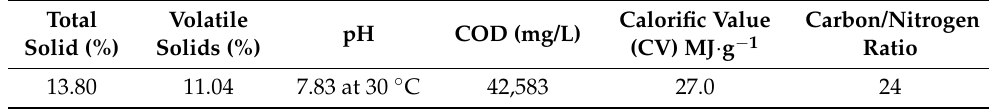
Figure 1. 3D surface plot of the dataset points and the model mesh for methane yield. [CH 4 reported in %, X and Y reported in %/°C, and % respectively]. Table 1. Characterization of cow dung used in the Table 1. Characterization of cow dung used in the study.